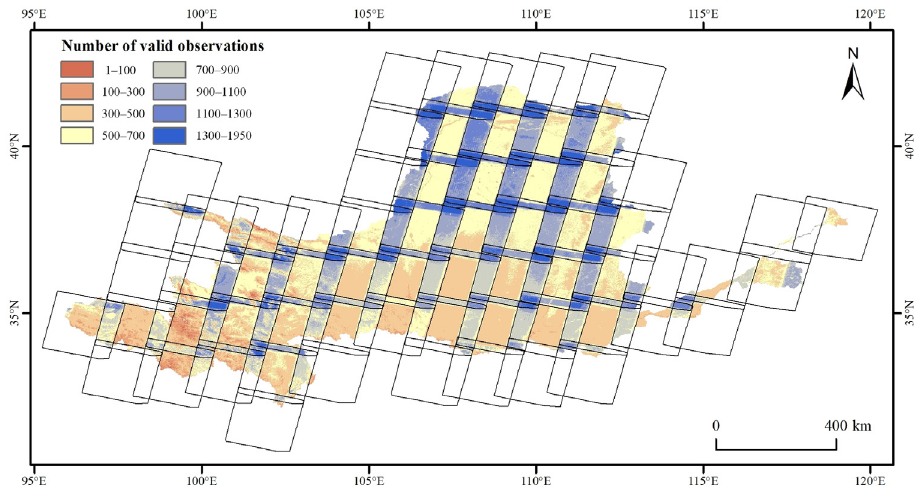
Figure 2. Spatial distribution of the frequency of clear Landsat observations in the YRB from 1986 to 2019.